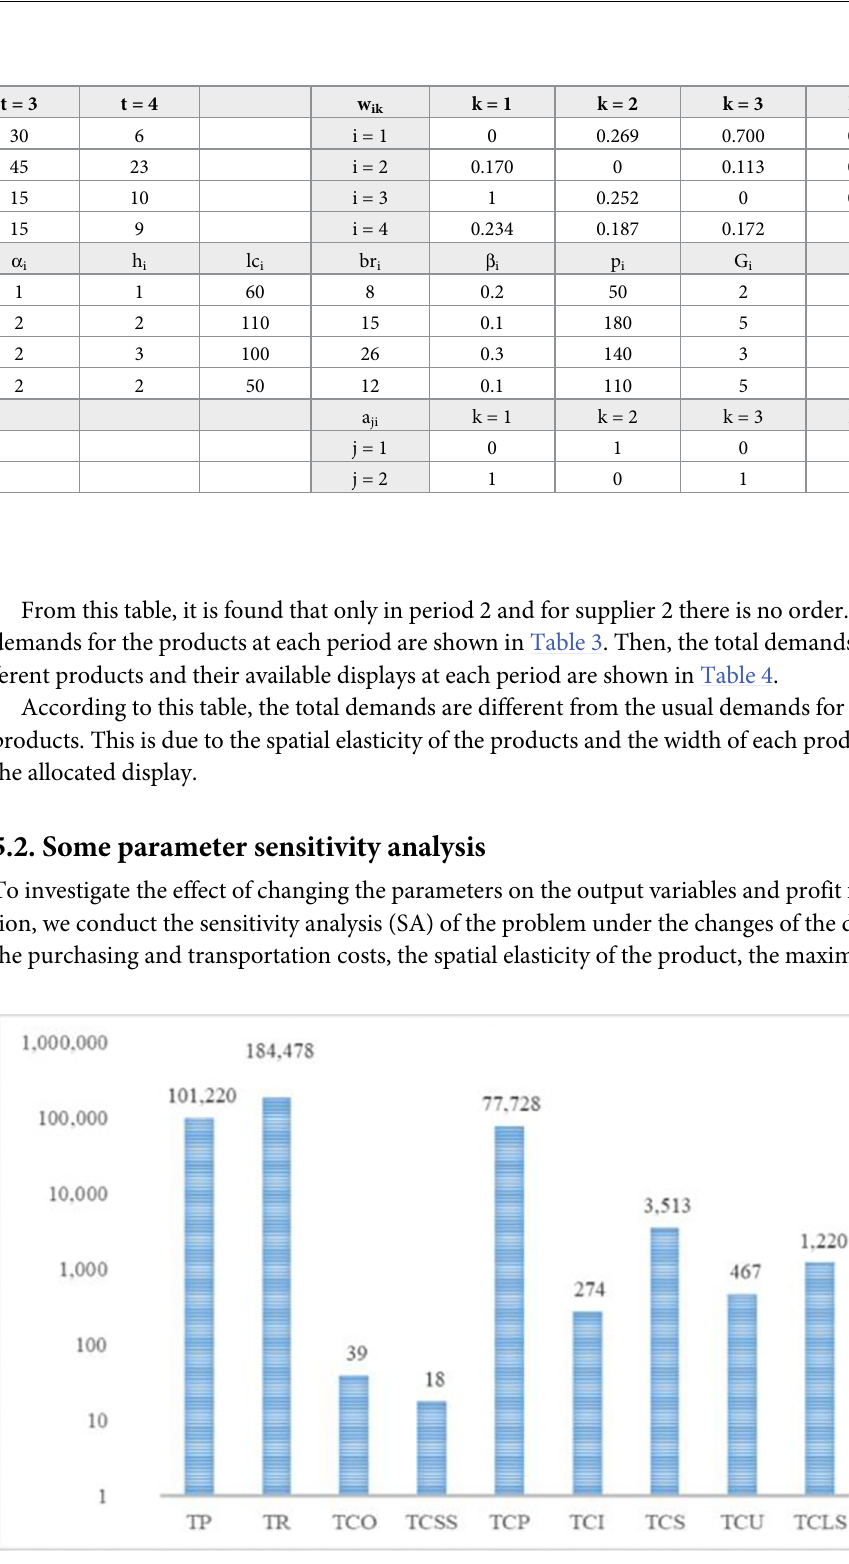
Fig 4. The different cost values and total profit of the small-scale sample